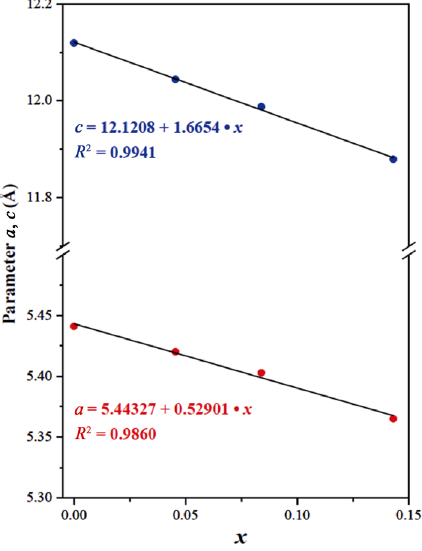
Fig. 2 Linear dependence of both a and c lattice constants vs. x parameter.